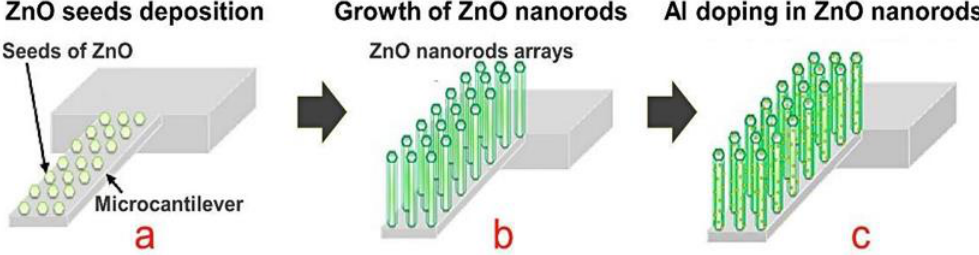
Figure 3. Growth process of Al-doped ZnO nanorods on microcantilever consisting of ( a ) ZnO seeds deposition; ( b ) the growth of ZnO nanorods; ( c ) Al doping in ZnO nanorods using radio frequency sputtering. Modified from reference [69].